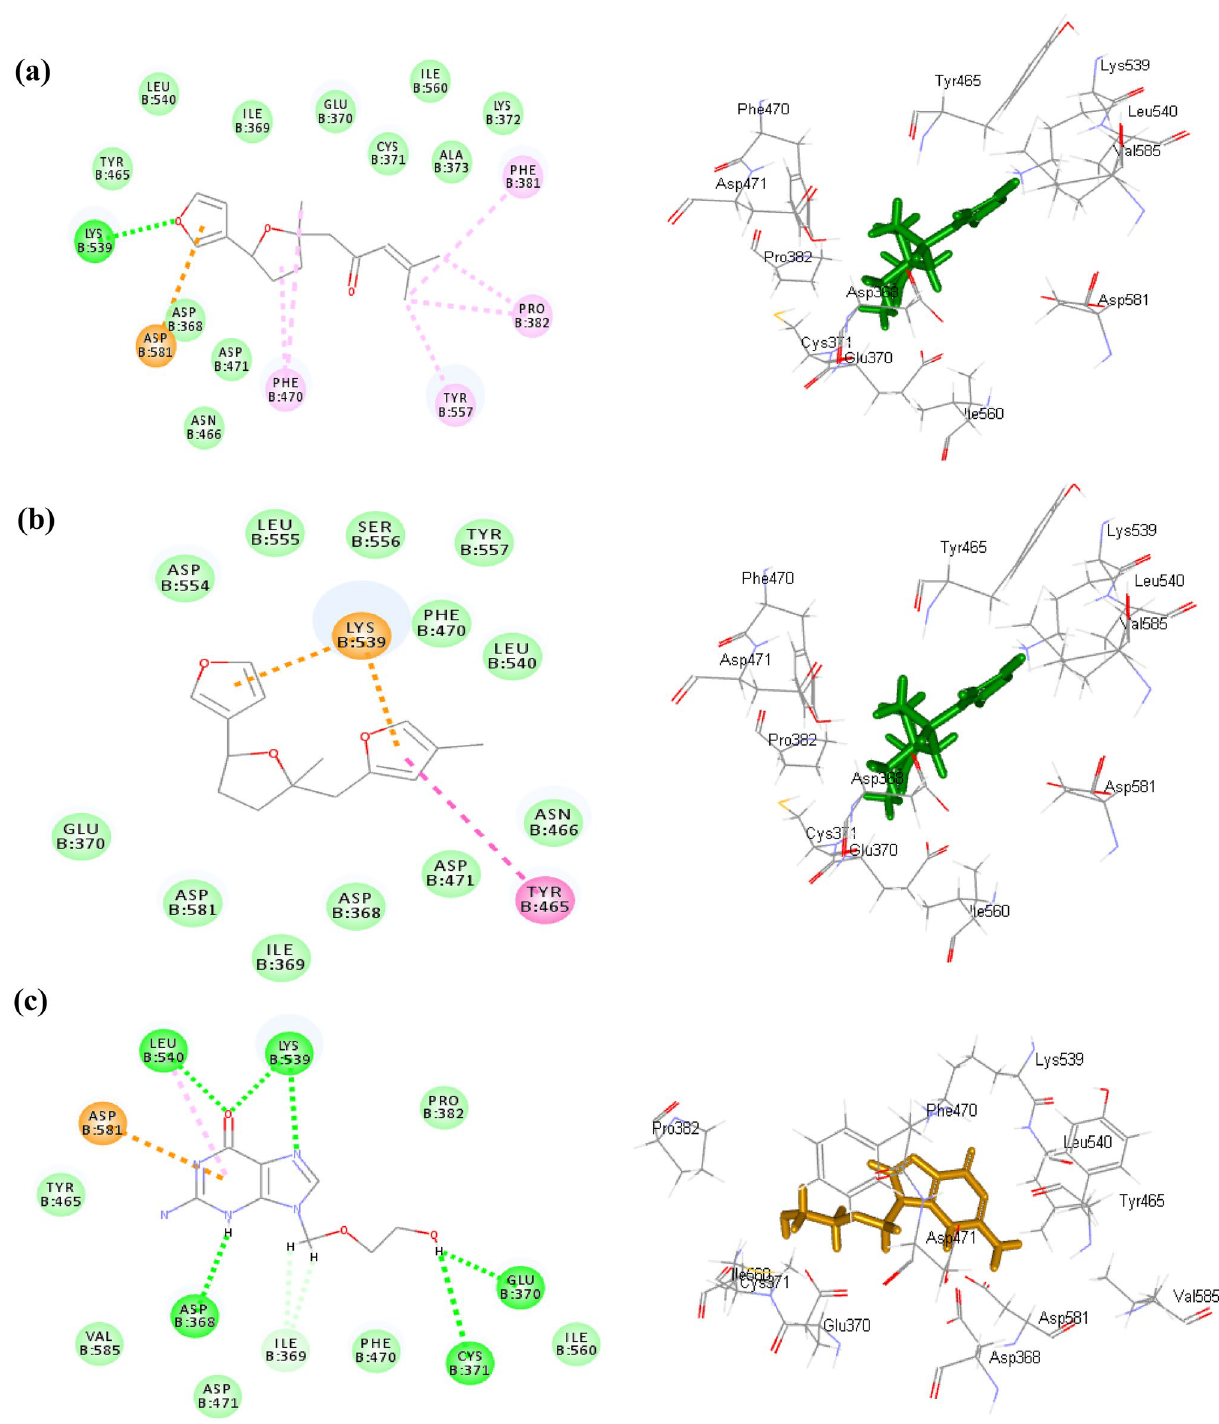
Figure 5. 2D and 3D interactions of dehydroepingaione ( a ), 2,3’-bifuran, 2,3,4,5-tetrahydro-5-methyl-5-[(4- methyl-2-furanyl)methyl] ( b ) and acyclovir ( c ) in the active site of HSV type-1 DNA polymerase